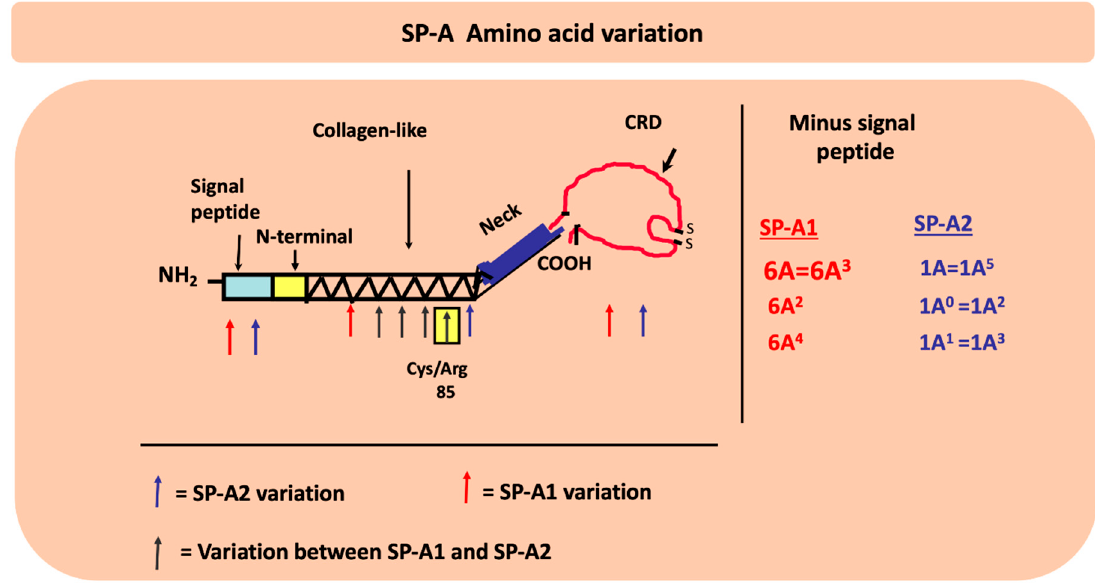
Figure 5. The location of the amino acid di ff erences between the SP-A1 and SP-A2 genetic variants as well as the amino acid di ff erences among variants are shown on the di ff erent SP-A protein regions (signal peptide, N-terminal, collagen-like, neck, and carbohydrate recognition domain (CRD)). The black arrows show the gene specific di ff erences where all the SP-A1 variants di ff er from all the SP-A2 variants. The blue and red arrows show di ff erences in SP-A2 and SP-A1 variants, respectively. Residue 85 is noted for its importance in function and biochemical properties between SP-A1 and SP-A2. After the signal peptide is removed, as shown, some of the variants become identical in their coding